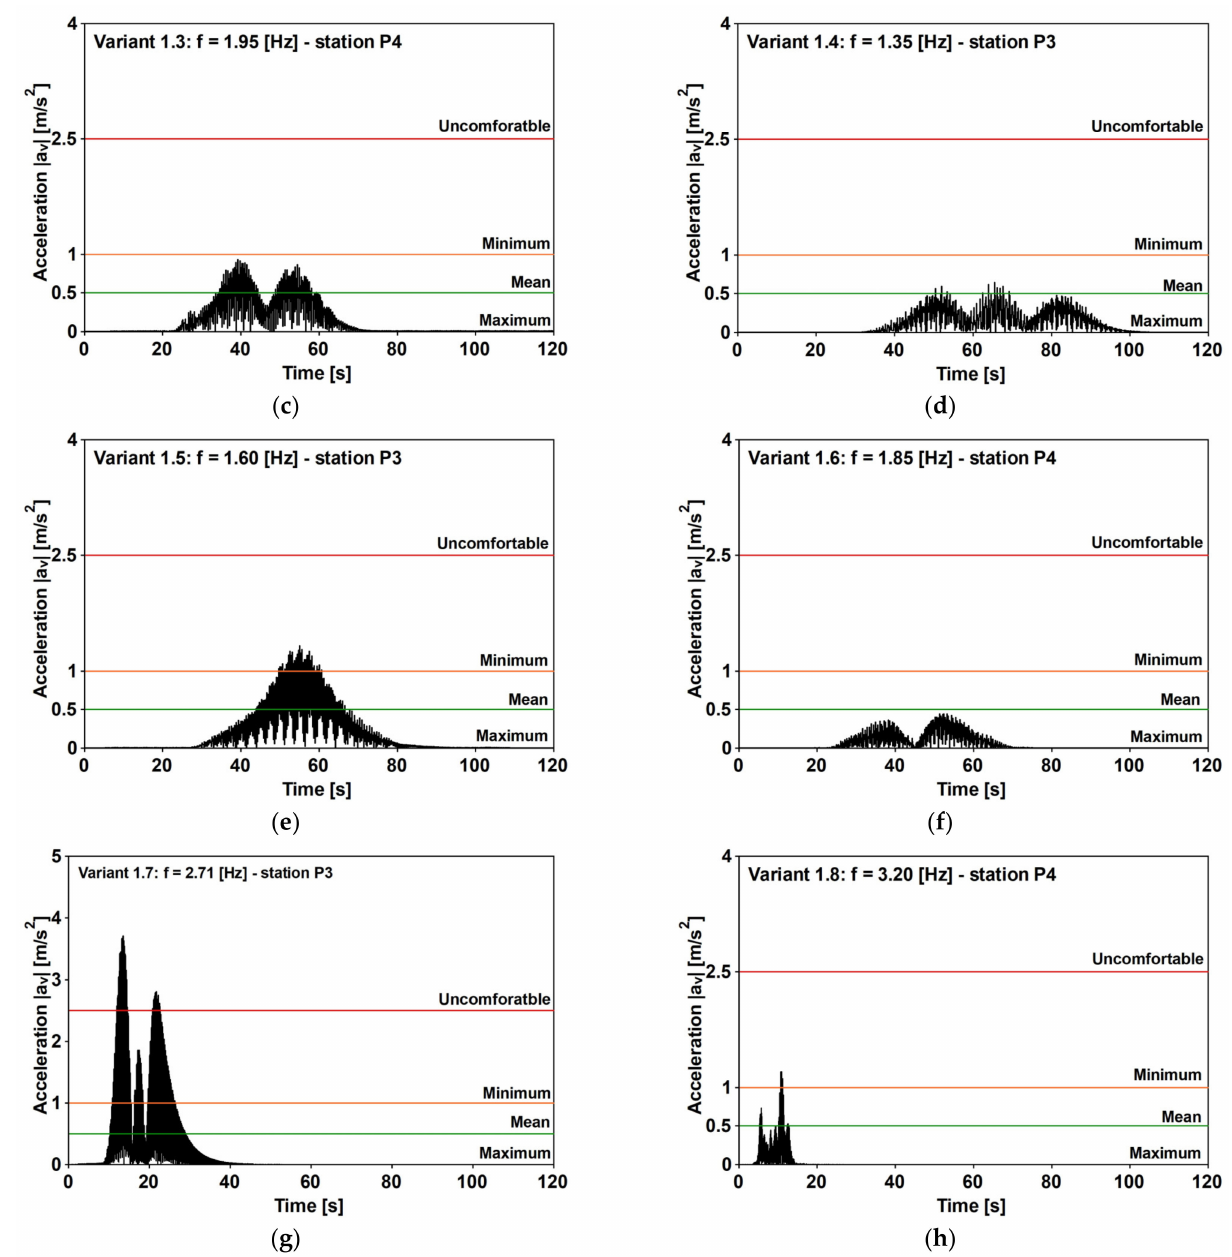
Figure 18. The absolute acceleration values vs. the S É TRA [36] comfort level. The walking ( a – f ) and running ( g , h ) simulations are according to the considered load variants (see Table